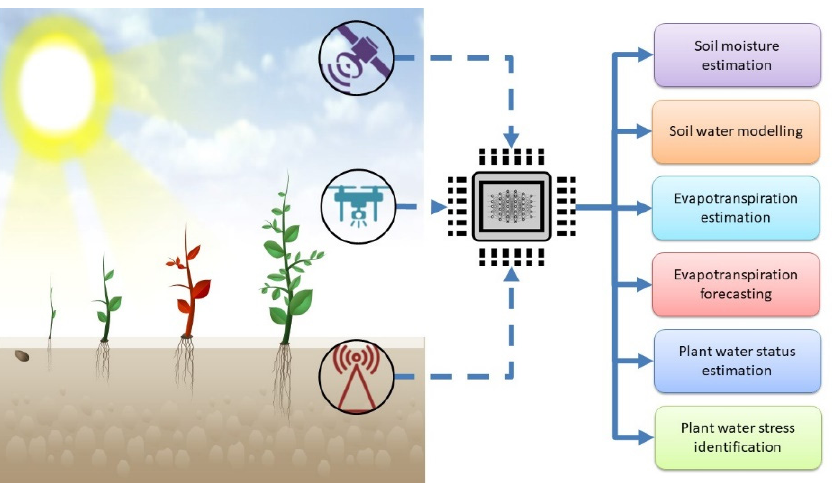
Figure 1. Plant water stress assessment methods based on state-of-the-art sensory measurements.